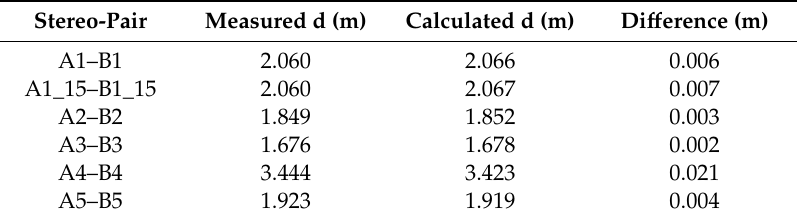
Table 3. Di ff erences between measured distances between images of each stereo-pair and distances calculated in photogrammetric